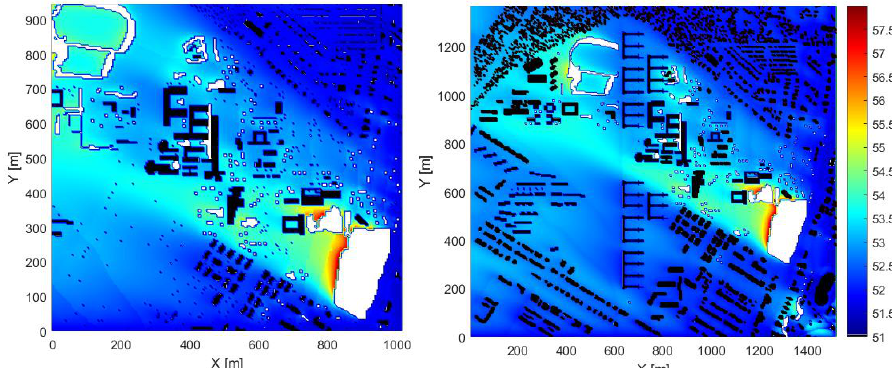
Figure 10. Relative humidity [%] at pedestrian level: on the left, in the current situation; on the right, in the planned situation. Energies 2020 , 13 , x FOR PEER REVIEW